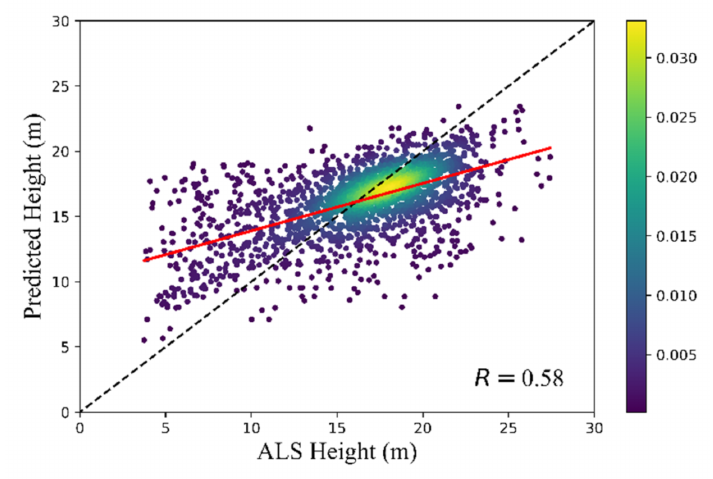
Figure 8. Cross-comparison between the h 90 metric of ALS and predicted forest canopy heights by RF. GEDI (Global Ecosystem Dynamics Investigation) is a new spaceborne LiDAR instru- ment operating onboard the International Space Station (ISS) and has been collecting data between ~51.6 ◦ N and ~51.6 ◦ S globally by a full waveform LiDAR since April 2019 [47]. By integrating GEDI data with optical metrics derived from Landsat analysis-ready data, a global forest canopy height map with 30 m resolution (GEDI-derived map) for the year 2019 was obtained (https://glad.umd.edu/dataset/gedi/ accessed on 15 September 2021) and the accuracy of the map was assessed quantitatively. In this study, the accuracy of the predicted forest canopy height map for Area 1 was further validated by conducting spatial analysis with GEDI-derived canopy height map. Figure 9a,b represent the predicted canopy height map and GEDI-derived canopy height map in 2019. By visual interpretation, it can be found that the spatial distributions of forest canopy height for these two maps show a similar pattern. For predicted forest canopy height map, the number of grids corresponding to canopy height between 18–24 m is the largest, and for GEDI-derived map, the pixels with canopy height between 15–21 m account for the largest proportion.